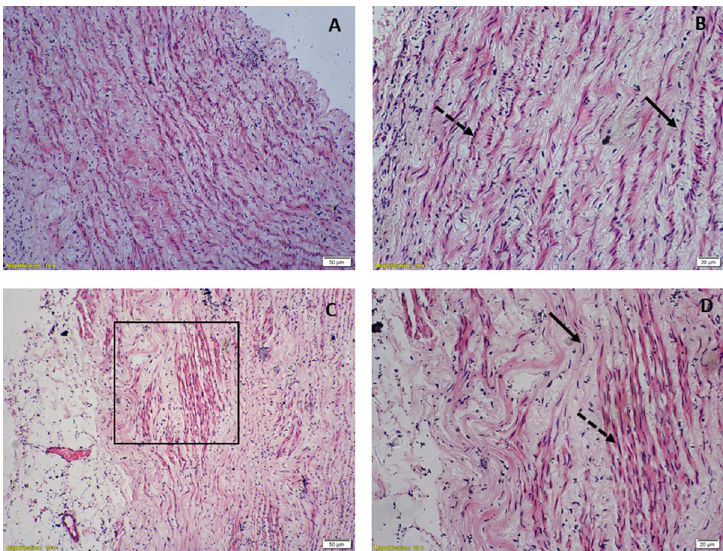
Fig 11. Hematoxylin & eosin stained light microscopic view of aorta, (A) & (B) Circular strip preparation showing elliptical nuclei of circular smooth muscle fibres (solid arrow) and round nuclei of longitudinal muscle fibres (dashed arrow) under 10X & 20X magnification respectively, (C) & (D) Longitudinal strip preparation showing elliptical nuclei of longitudinal smooth muscle fibres and round nuclei of circular smooth muscle fibres under 10X & 20X magnification